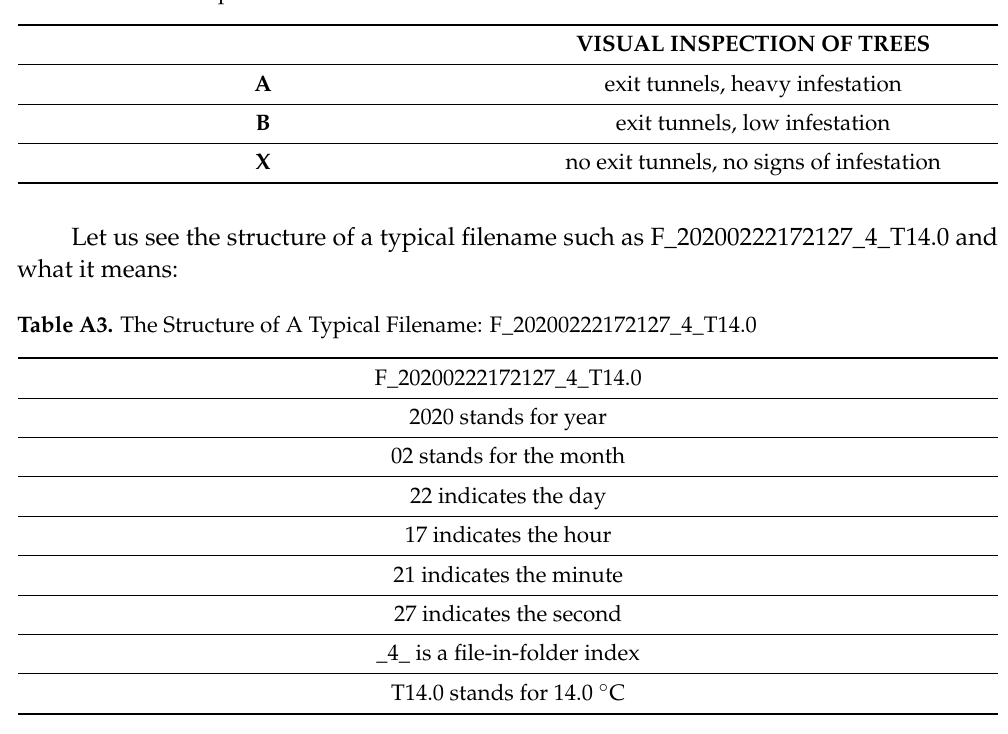
Table A2. Visual Inspection of Trees.